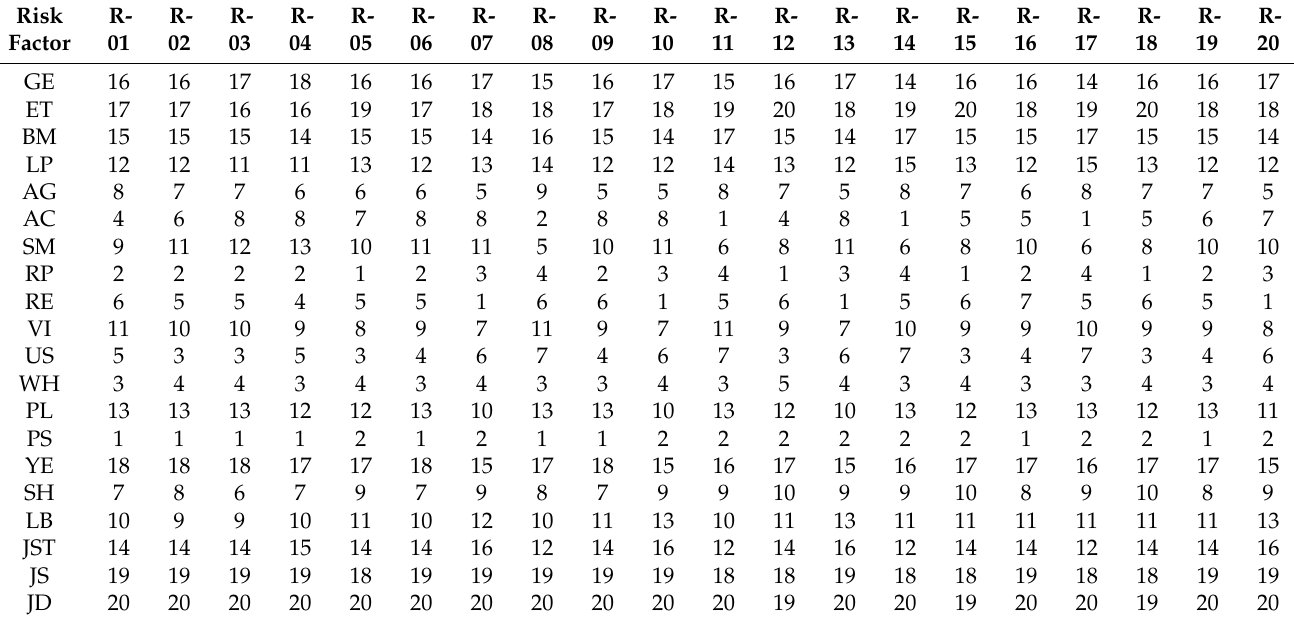
Table 17. Variation in criteria rank due to change in expert’s